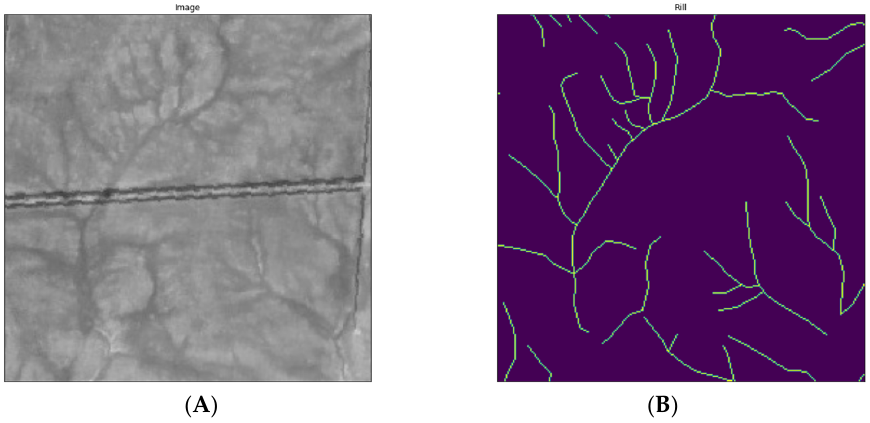
Figure 3. Example of a satellite image patch ( A ) and a binary mask ( B ) of rill erosion.